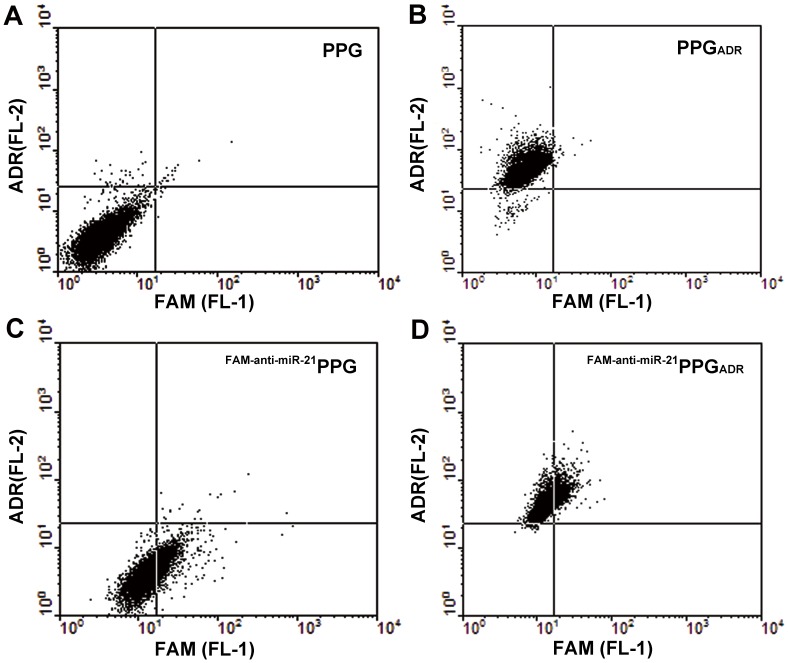
Characterization by flow cytometry of PPG co-delivering anti-miR-21 and ADR.MCF-7/ADR cells were incubated with PPGADR, FAM-anti-miR-21PPG, FAM-anti-miR-21PPGADR at 37°C for 4 h and harvested for flow cytometry analysis. Cells treated with blank PPG served as a control.